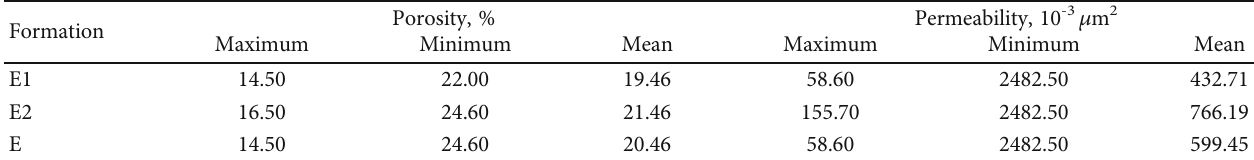
Table 6: Reservoir physical property statistics for logging interpretation in block Yingmai 7.